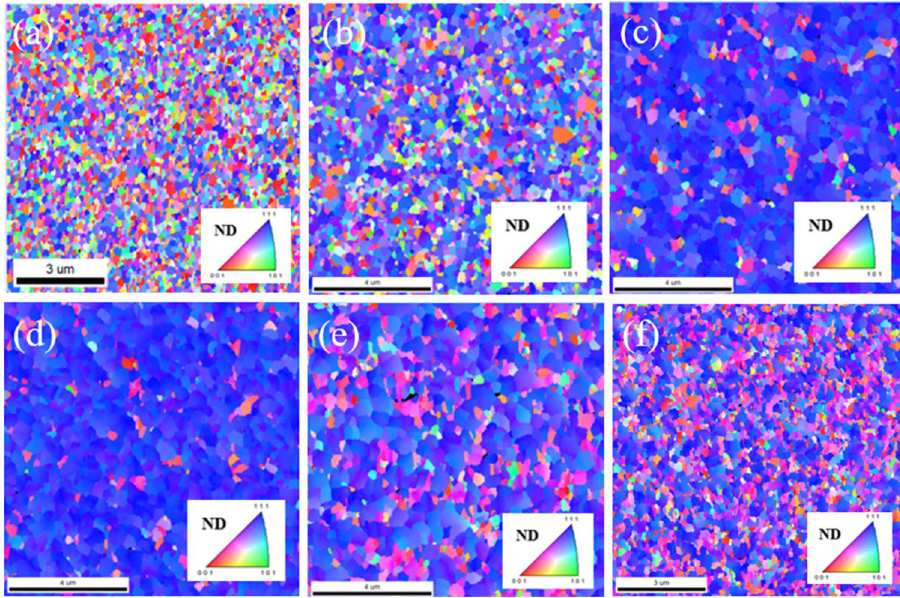
Figure 5. Plan-view EBSD inverse pole figure (IPF) maps of sputtered Cu films deposited with substrate biases of ( a ) 0 V, ( b ) − 50 V, ( c ) − 100 V, ( d ) − 150 V, ( e ) − 200 V and ( f ) − 250 V.